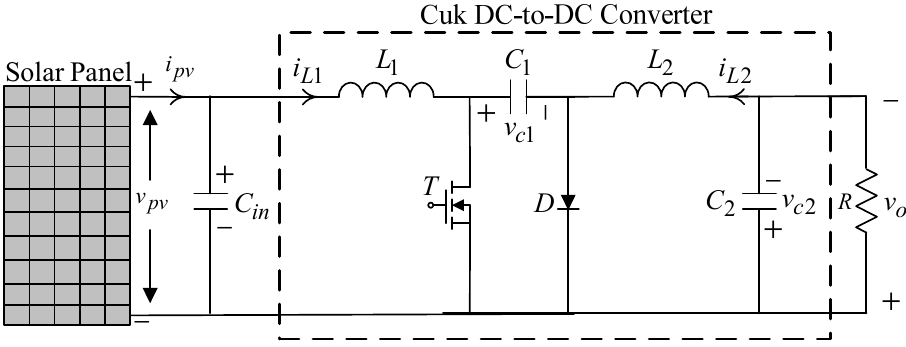
Figure 1. Construction of a Cuk DC-to-DC converter.